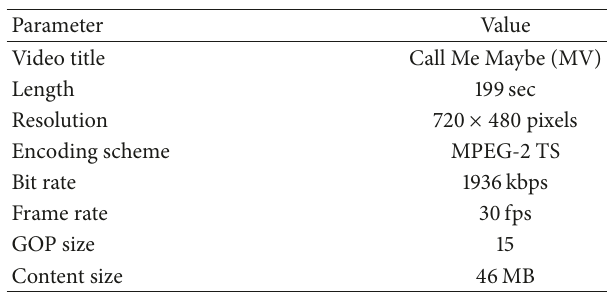
Table 4: Initial playout delay QoS d and corresponding QoE. Table 5: Information of test video